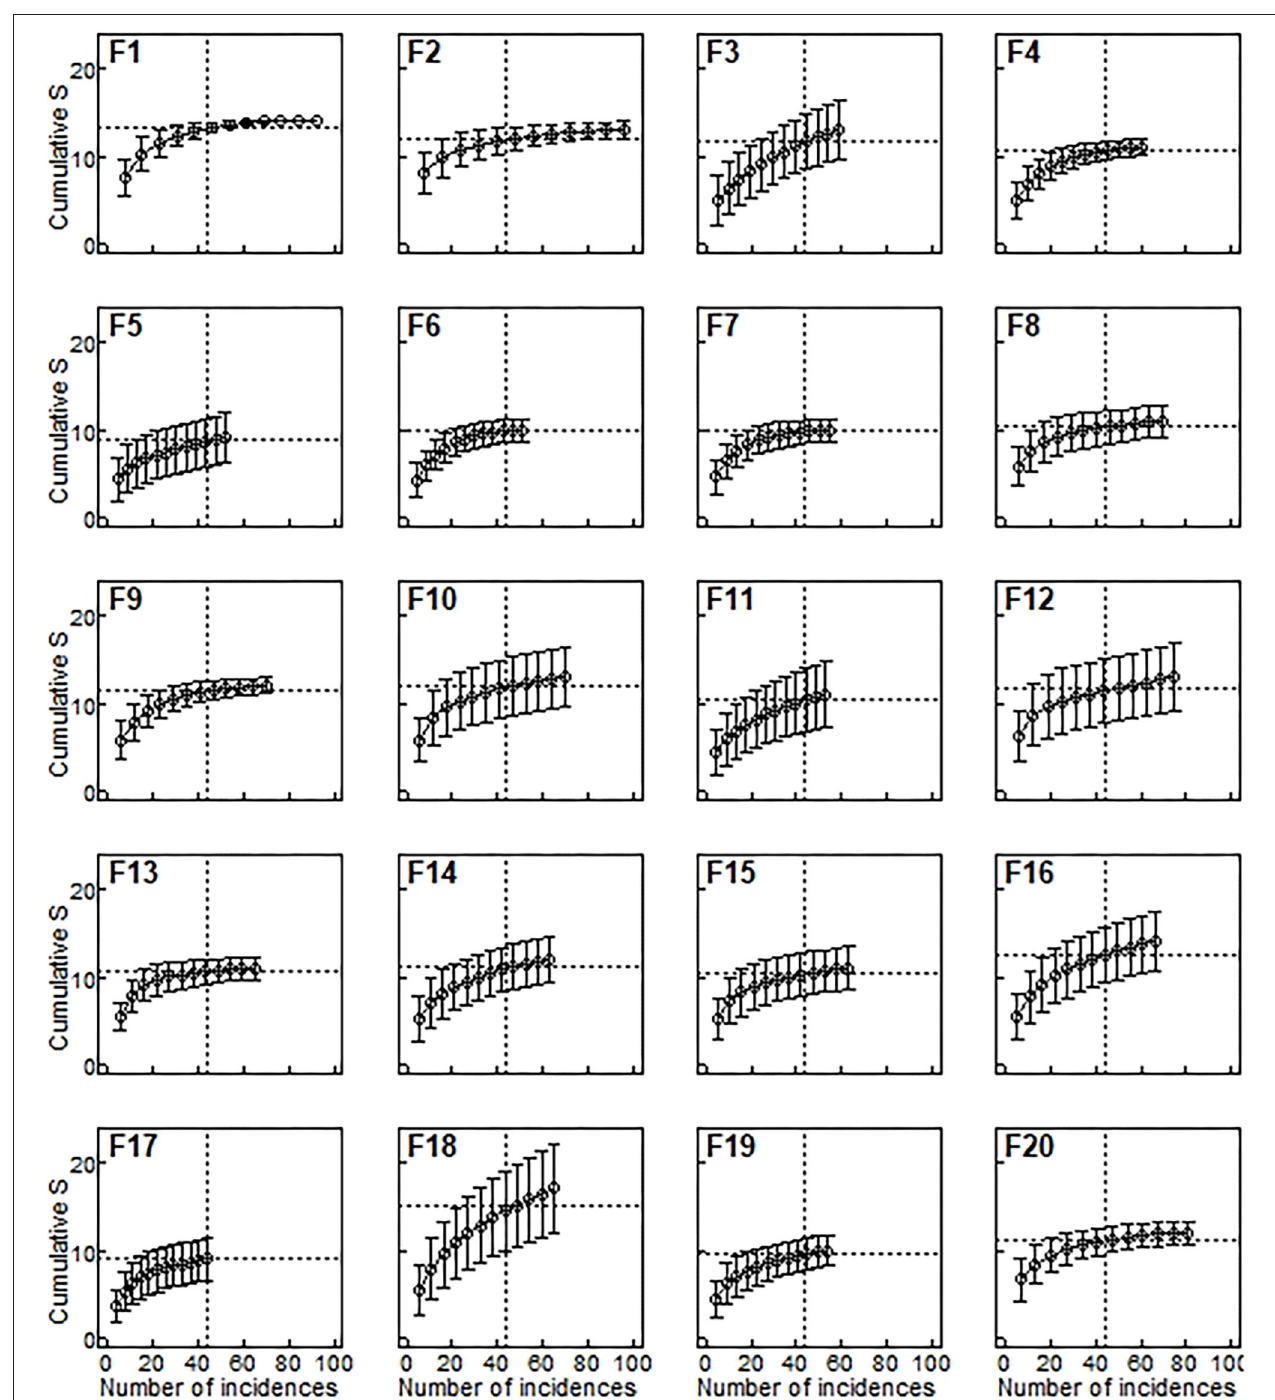
FIGURE 3 | Species richness estimated from rarefaction curves for each remnant. Species richness (horizontal lines) was estimated as the expected number of species for 44 occurrences (vertical lines), which was the minimum number of occurrences observed in any of the 20 plots (F17). Occurrence-based rarefaction curves (Gotelli and Colwell, 2011) were estimated by averaging 500 resamples with replacement. Bars are ± 95%confidence intervals.